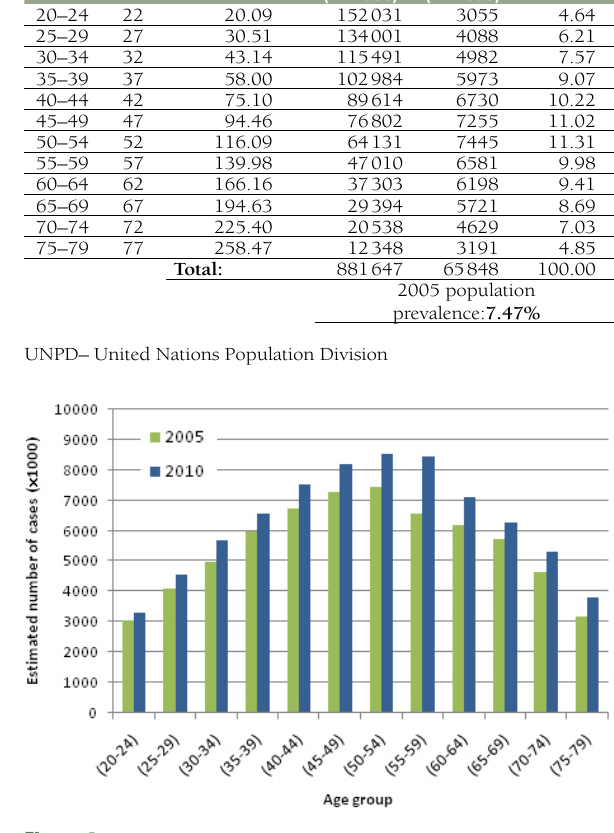
Figure 4. Estimated numbers of type 2 diabetes cases in Southern Asia (in thousands) by age group in 2005 and